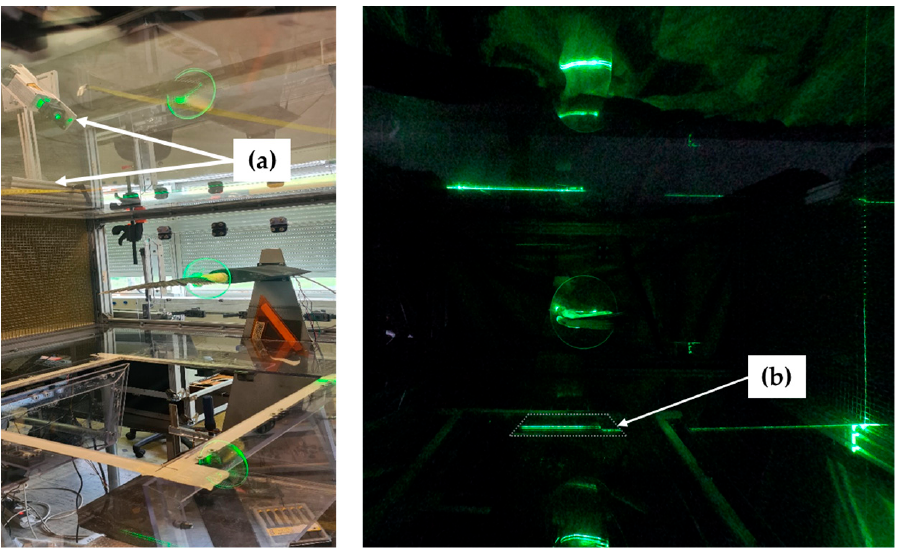
Figure 4. Set ‐ up of the laser scan methodology: ( a ) Laser ‐ line device and rail, ( b ) Surface mirror on Figure 4. Set-up of the laser scan methodology: (a) Laser-line device and rail, (b) Surface mirror on the section floor. the section